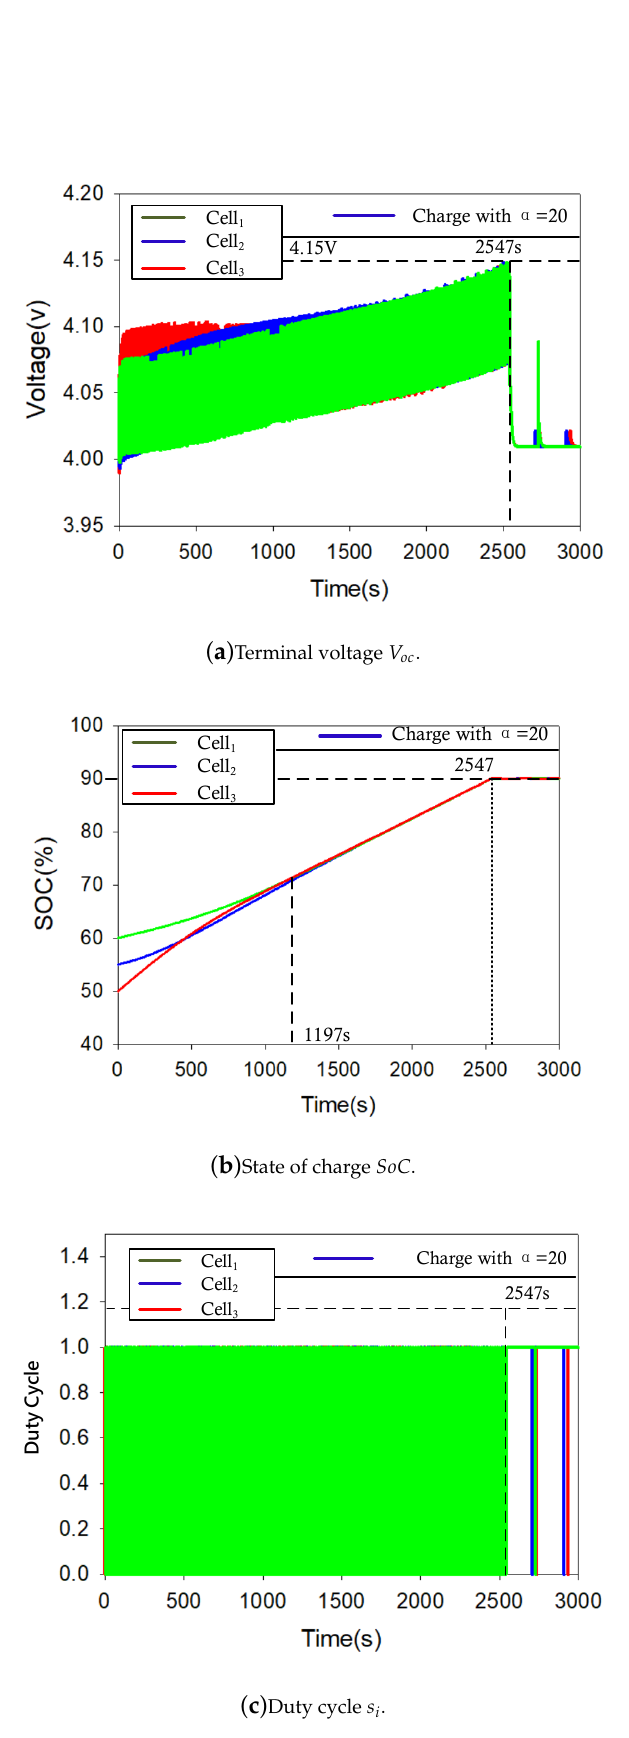
Figure 10. Results of the artificial potential field method with α =